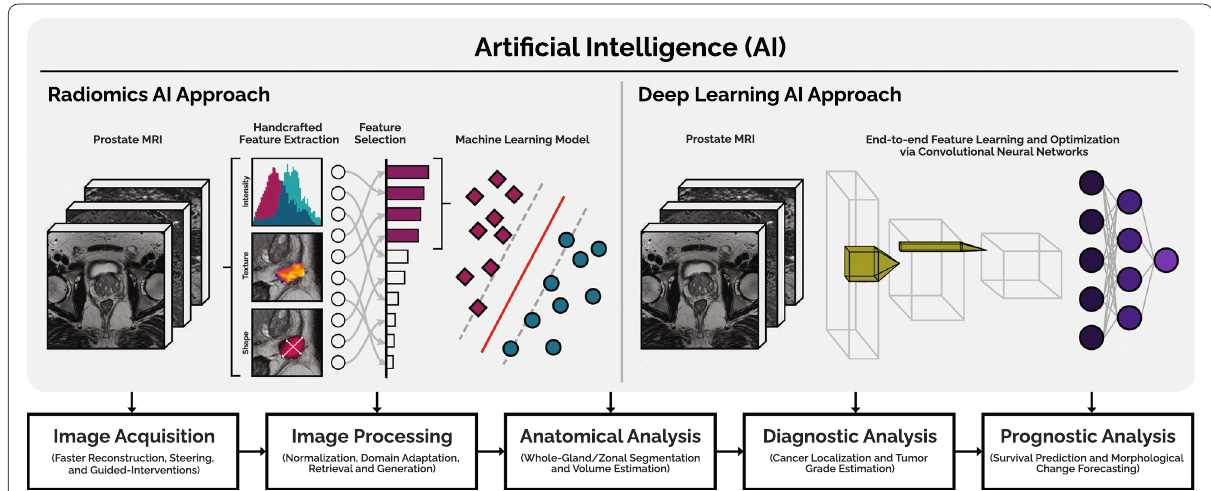
Fig. 1 Use of artificial intelligence in the radiological workflow of prostate magnetic resonance imaging to automate, improve, and support critical tasks, considering radiomics and deep learning